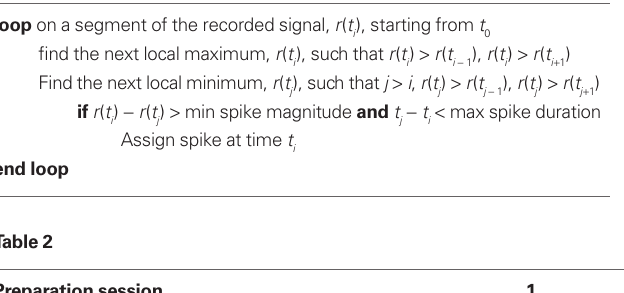
loop on a segment of the recorded signal, r ( t fi nd the next local maximum, r ( t Find the next local minimum, r ( t